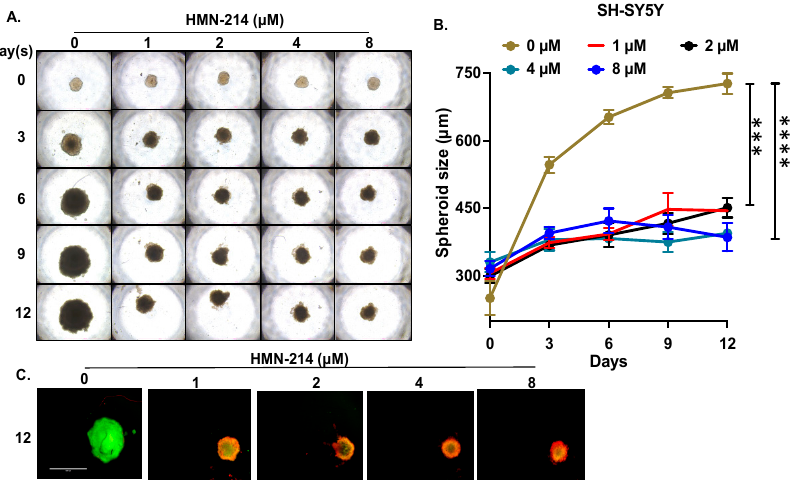
Figure 6. HMN-214 inhibits MYCN-non-amplified SH-SY5Y NB spheroid tumor growth. ( A ) Rep- resentative images of SH-SY5Y NB spheroidal tumors. ( B ) Spheroid tumor growth measurements in response to different concentrations of HMN-214 treatment at different days. ( C ) Representative fluorescent images of Day 12 spheroidal images stained with Calcein AM (Green; live cells) and EthD-III (Red; dead cells) fluorescence dyes. *** p < 0.001, **** p < 0.0001.